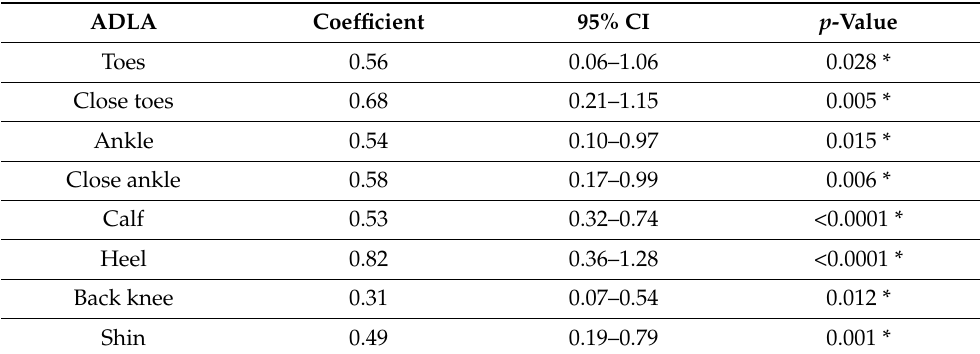
Table 2. Increase in temperature at eight regions of interest (ROIs) in participants with a history of ADLA compared to participants who had never had